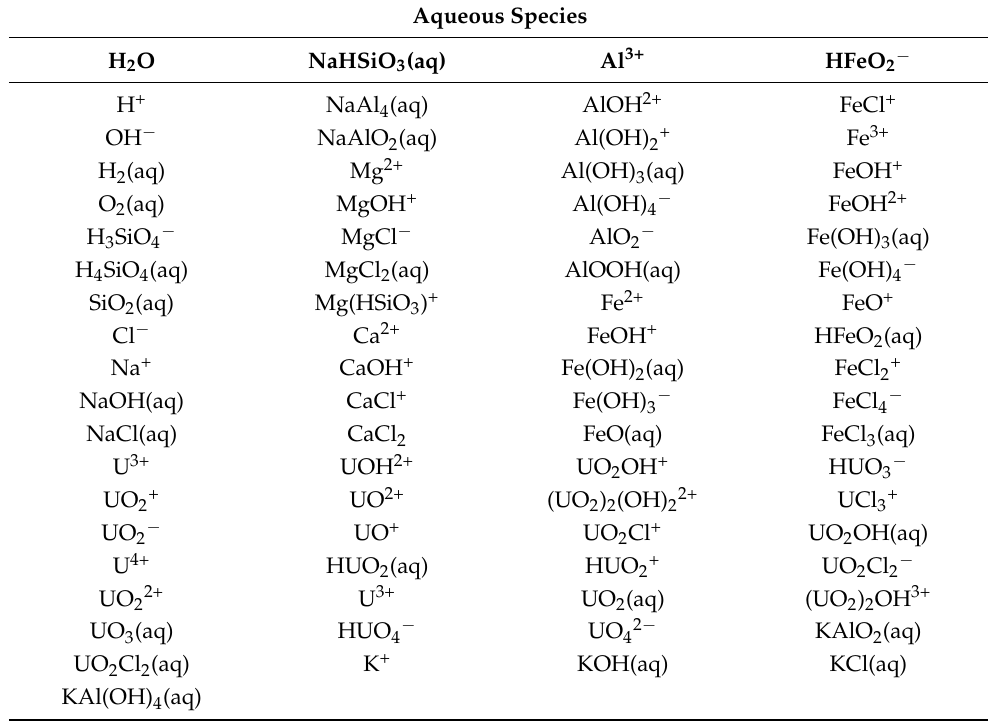
Table A2. The aqueous species included in the modeling of typical and “oxidized” pelite.